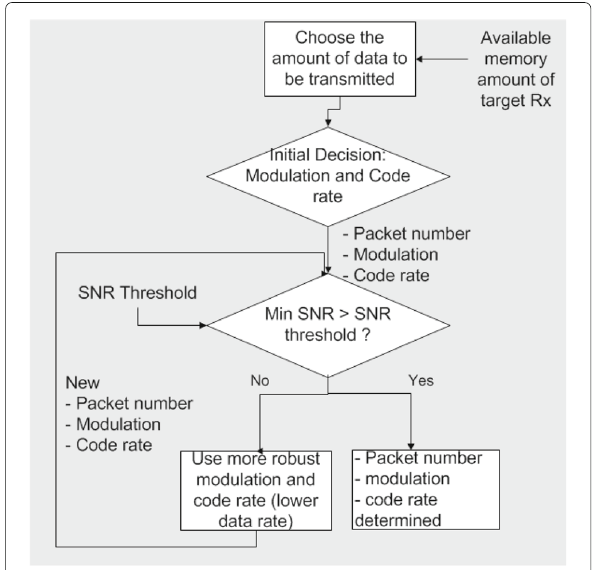
Fig. 6 Decision flow of the transmission